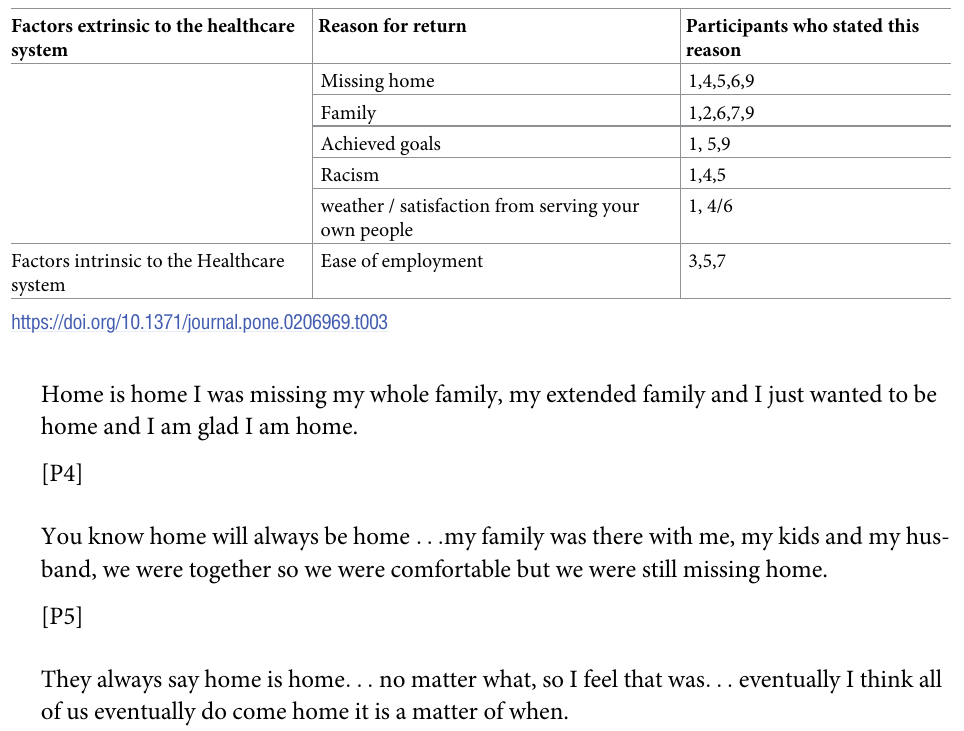
Table 3. Reasons and facilitators of return